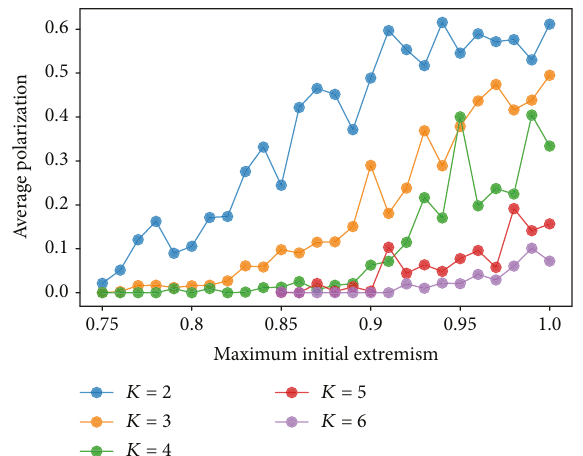
Figure 7: Average fi nal polarization for di ff erent cultural complexities over maximum initial opinion magnitude, S . Averages are roughly zero for S < 0 75 for all cultural complexities.